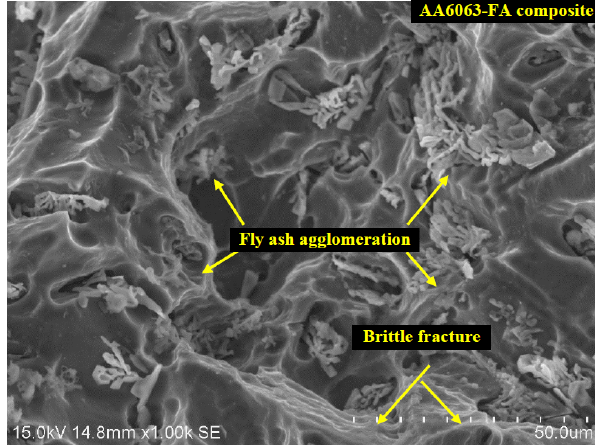
Figure 12. VP ‐ SEM fractography of AA6063 ‐ FA composite with 6 wt % fly ash.